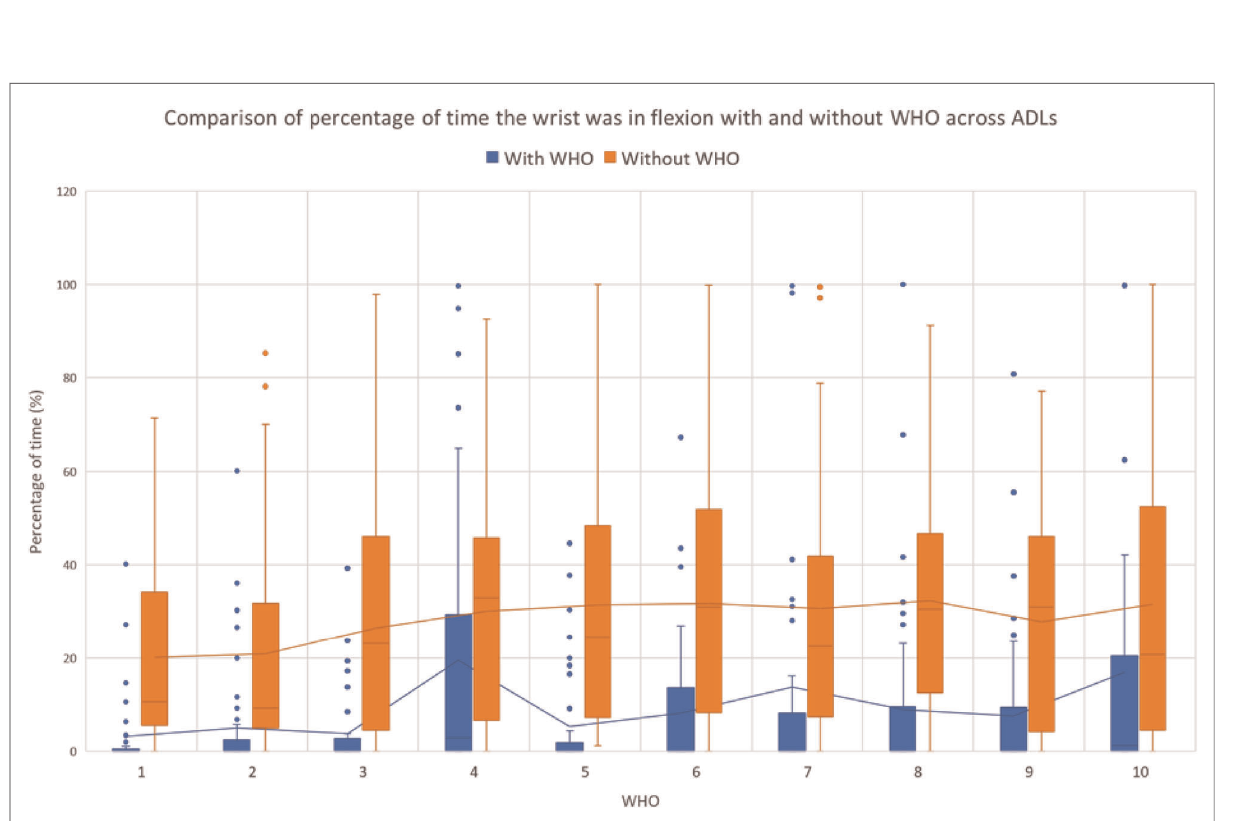
FIGURE 6 Example of a random participant ’ s pronation and supination during each ADL with and without WHO#2. In each graph, the difference in amplitude, range of motion, and time taken to complete tasks are shown. The positive angles imply pronation, and the negative ones imply